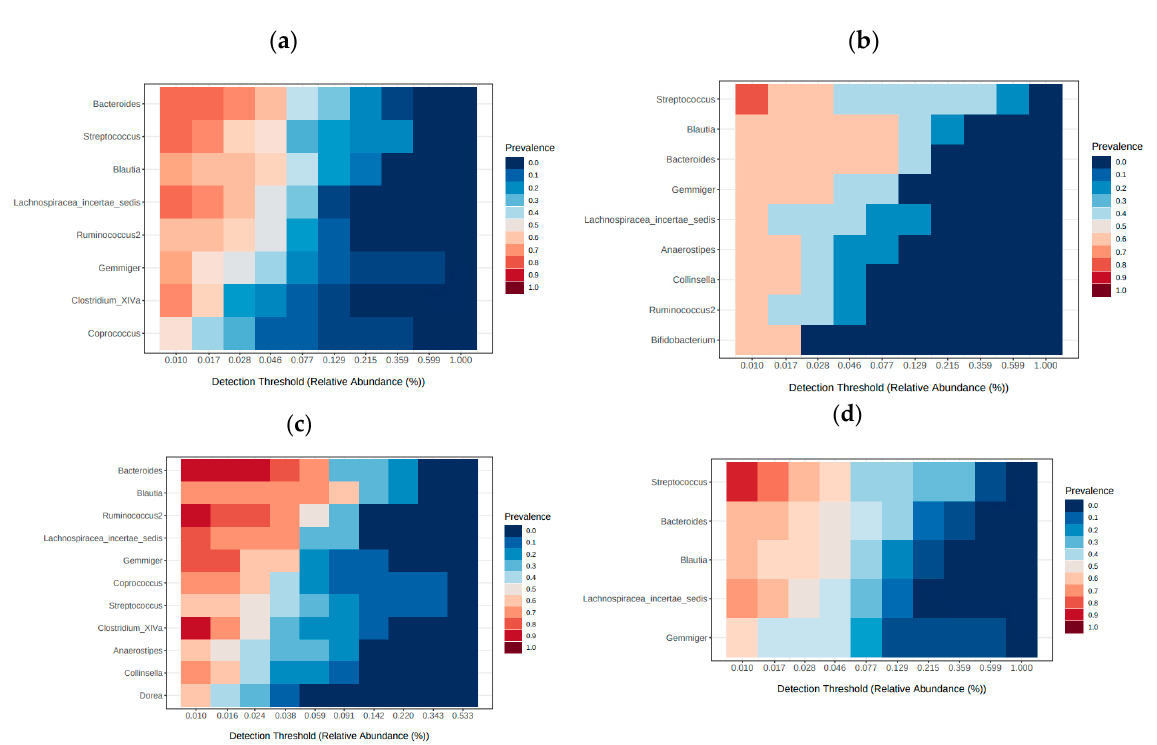
Figure 9. The ileal microbiome profile, taxonomic analysis: ( a ) Pie chart of the microbiome abun- dance profile of the terminal ileum. The inner circle represents the family level, and the outer circle represents the genus level. Microbiome profiles classified according to tumor location and MSS sta-